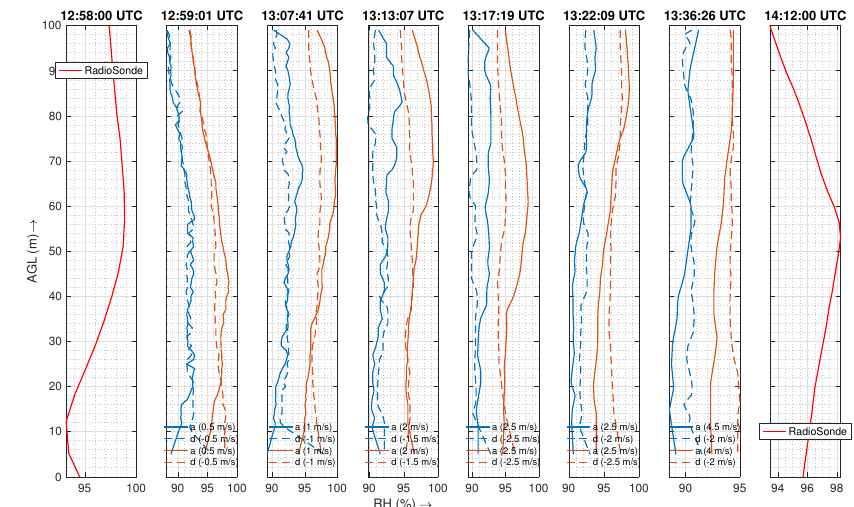
( a ) Temperature (T). The blue lines represent P1XQ2, and the orange lines represent P2XQ2.